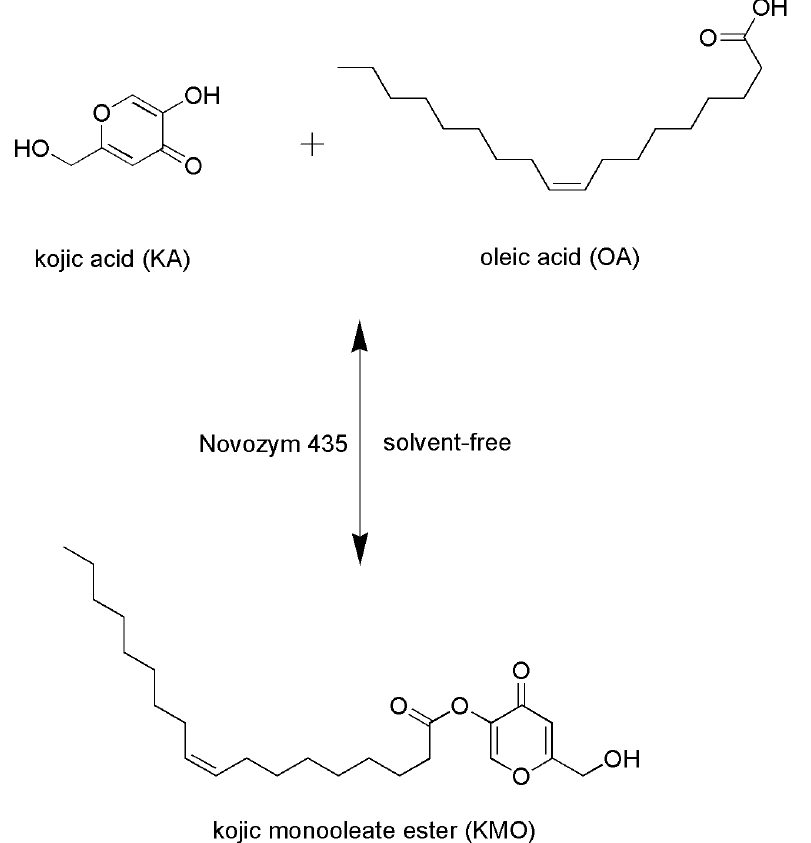
Fig 1. Enzymatic synthesis of kojic monooleate ester in solvent-free system.